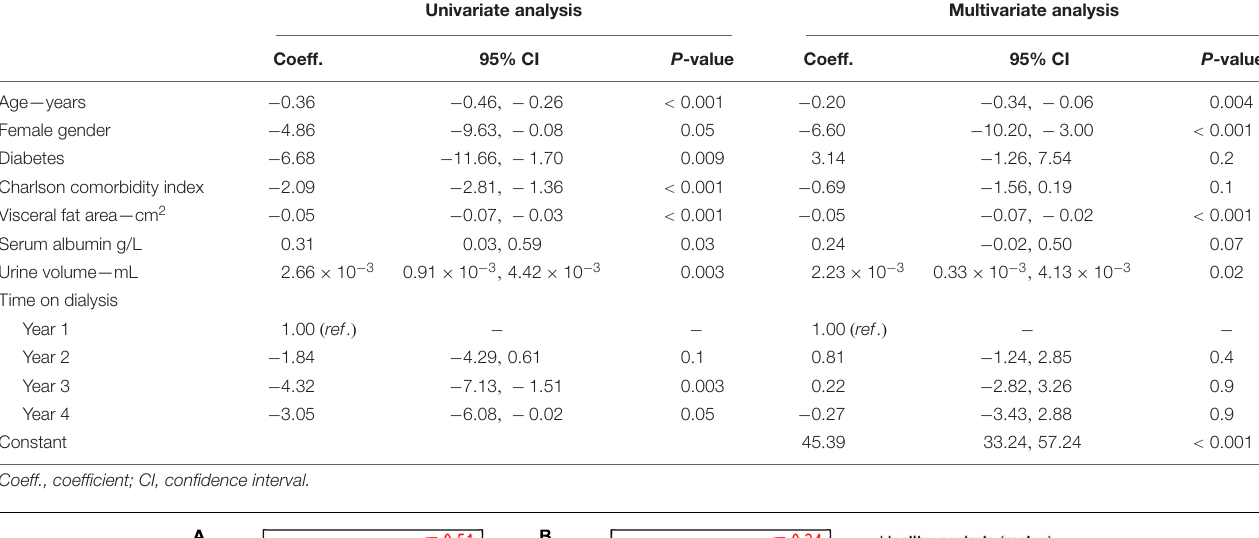
TABLE 3 | Determinants of MRA in patients with kidney failure treated with PD. Univariate analysis Multivariate analysis